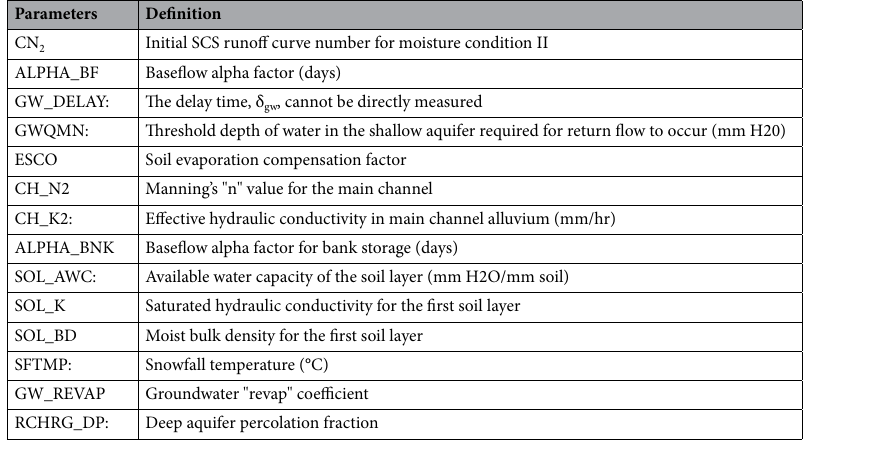
Table 1. Definitions of selected input parameters in SWAT 37